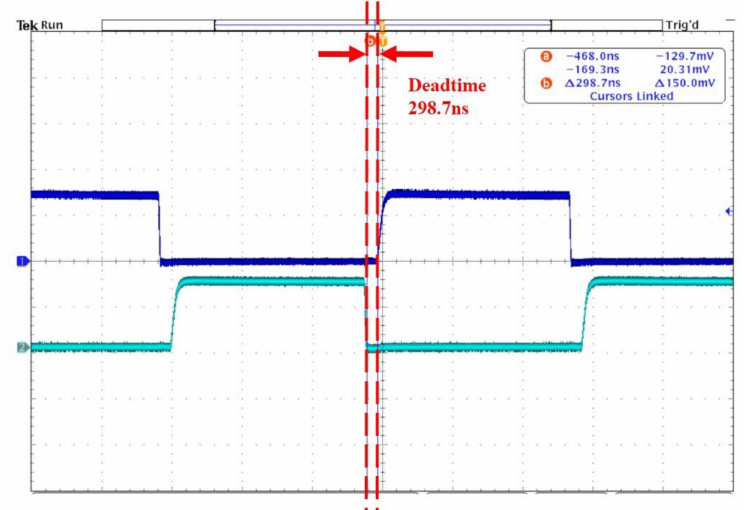
Figure 17. Waveforms of the gating signal on the primary side showing the deadtime interval.